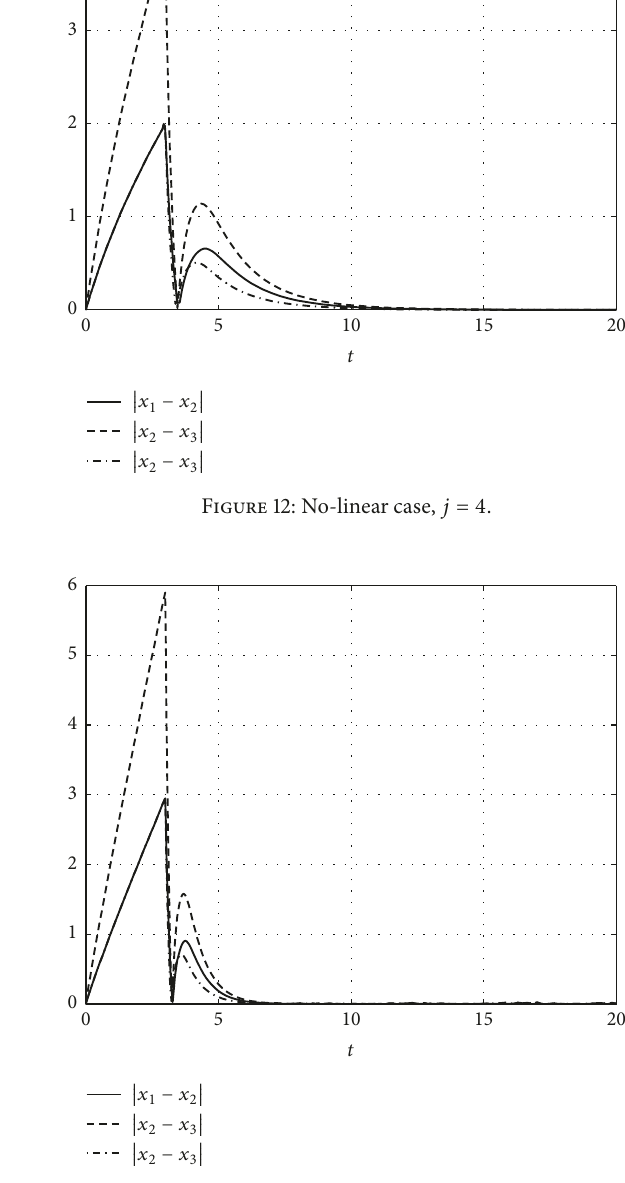
Figure 13: No-linear case, 𝑗 = 5